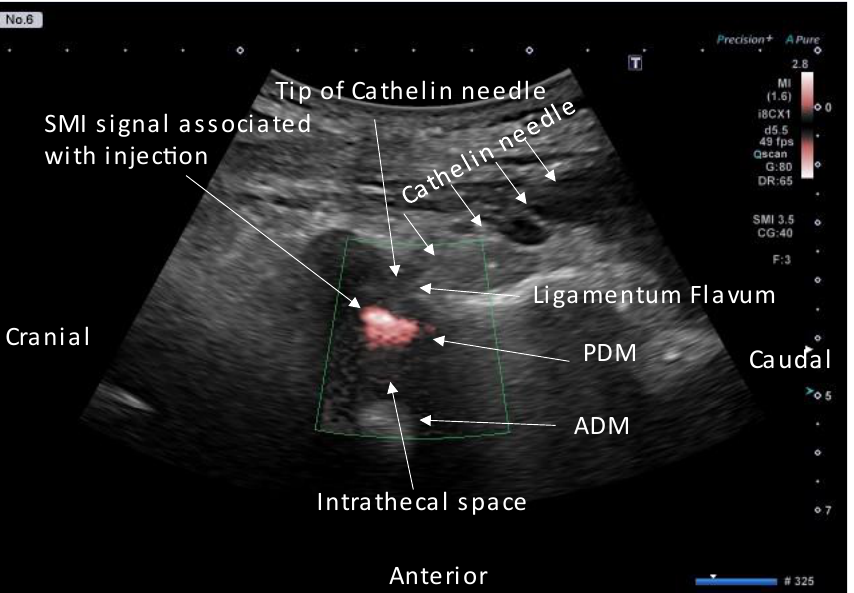
SMI signal at the L4/5 and L5/S1 interlaminar spaces without stenosis. The ( right ) image shows the SMI at the L4/5 and L5/S1 interlaminar spaces with an L5/S1 disc herniation. Strong SMI signals were observed at the site of stenosis with disc herniation. Abbreviations: L. flavum, ligamentum flavum; L, lumbar; SMI, superb microvascular imaging.